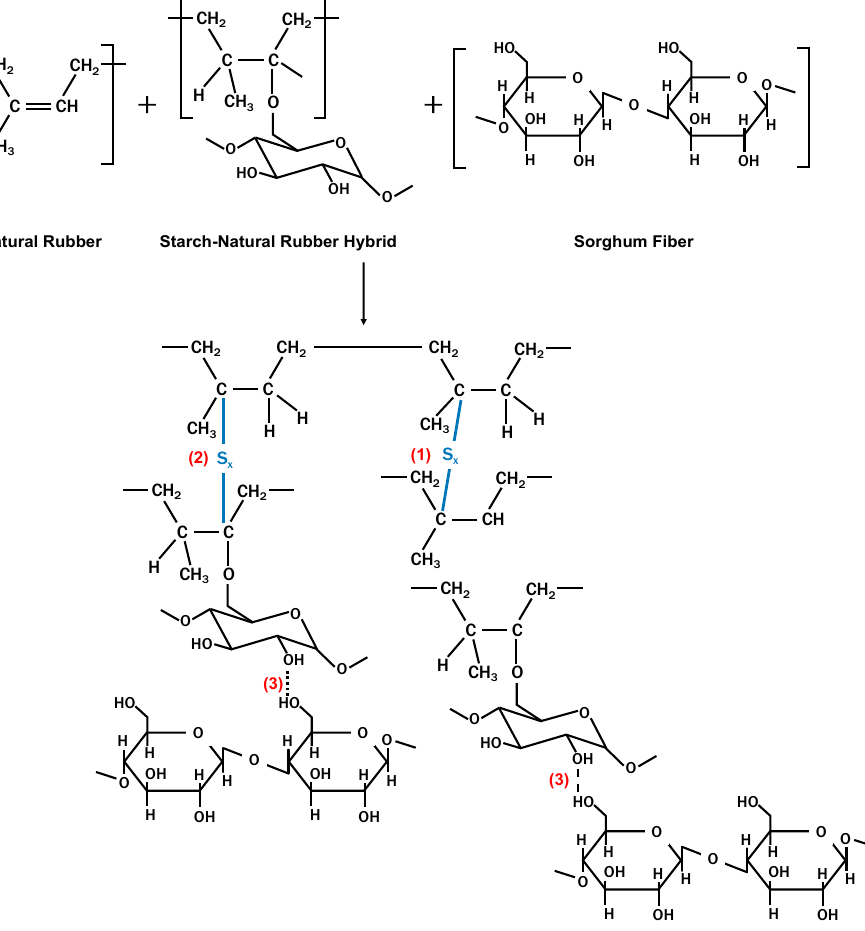
Figure 2. Proposed crosslinking bonds and intermolecular bonding in natural (sorghum) fibers-filled in natural rubber composite, added NR-g-St coupling agent.